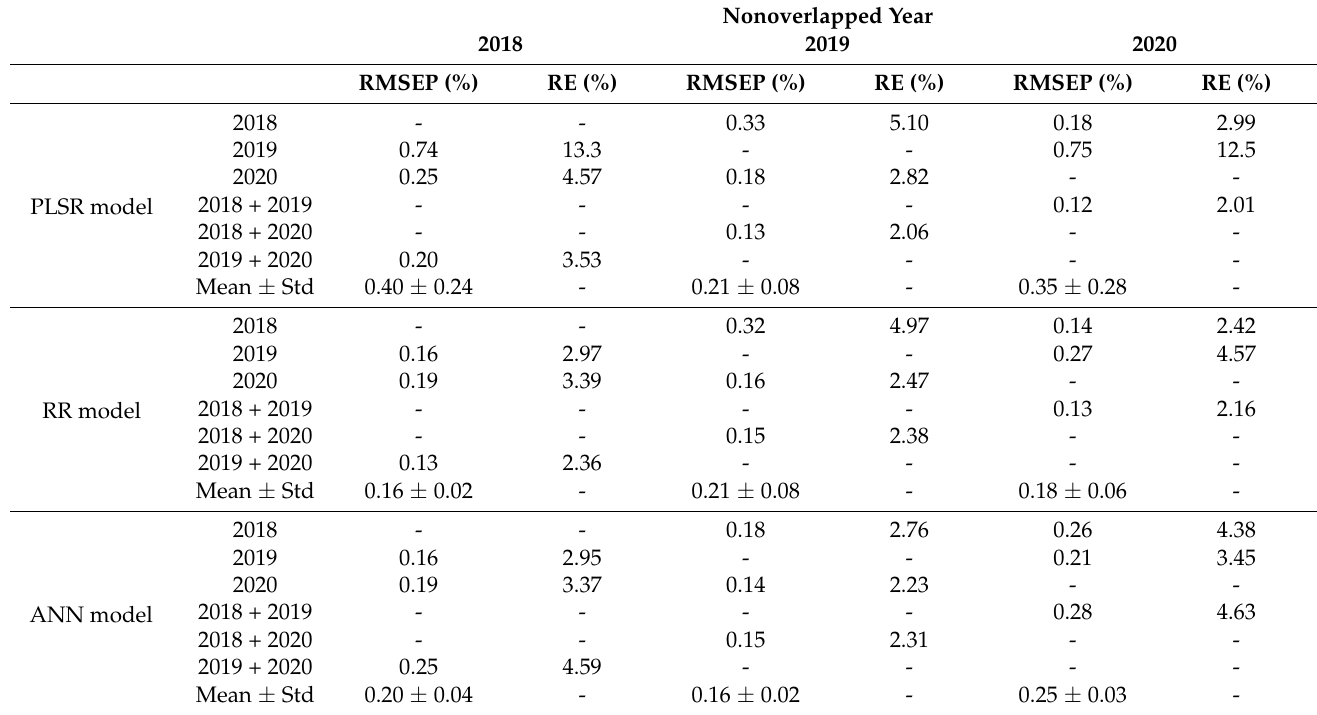
Table 8. Mutual prediction of the rice-protein content by cross-validation with nonoverlapped years using PLSR, RR, and ANN models in single- and multi-year analyses.